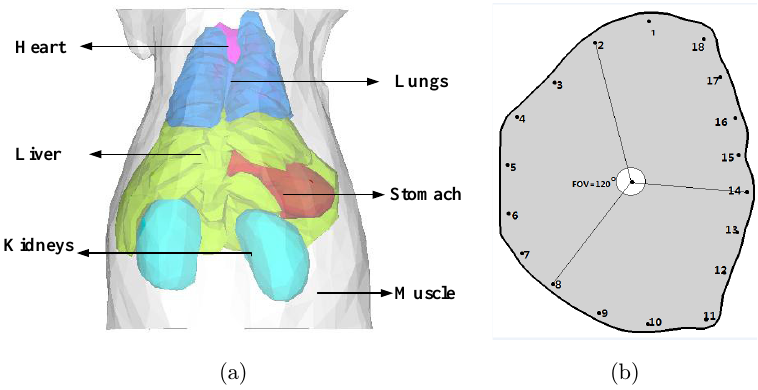
Fig. 1. (a) Torso of the mouse atlas model (b) The plane of excitation sources at z ¼ 16 : 5 mm. For each excitation source, °uorescence is detected at the opposite side with a 120 (cid:6) FOV.